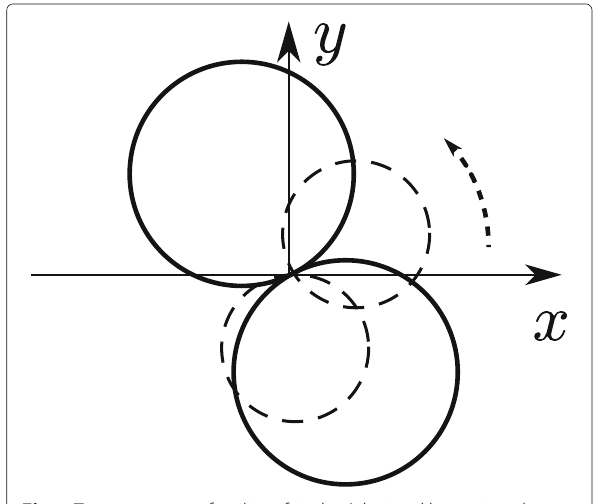
Fig. 5 Two parameters families of circles (obtained by varying the amplitude and applying the symmetry of revolution) which are projections of geodesics of the Heisenberg-Brockett-Dido